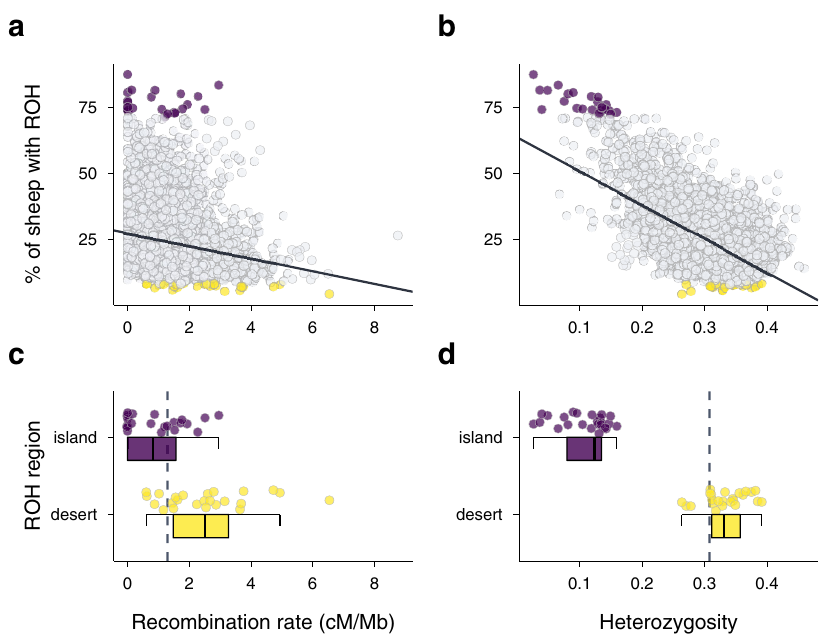
Fig. 2 Correlates of ROH density variation across the genome. Runs of homozygosity (ROH) density, recombination rate and heterozygosity were quanti fi ed in non-overlapping 500 Kb windows, with each point representing one window. The top 0.5% of windows with the highest and lowest ROH density in the population, termed ROH islands ( n = 24) and deserts ( n = 24), are coloured in purple and yellow respectively in all four plots. a Relationship between ROH density and recombination rate. b Relationship of ROH density and SNP heterozygosity. c Recombination rate within ROH islands and deserts. d Heterozygosity within ROH islands and deserts. Solid lines in a and b are linear regression lines and dashed lines in c and d are genome-wide means. Boxplots show the median as a centre line with the bounds of the box as 25th and 75th percentiles and upper and lower whiskers as largest and smallest value but no further than 1.5 * inter-quartile range from the hinge. Source data for this fi gure are also provided as a source data fi